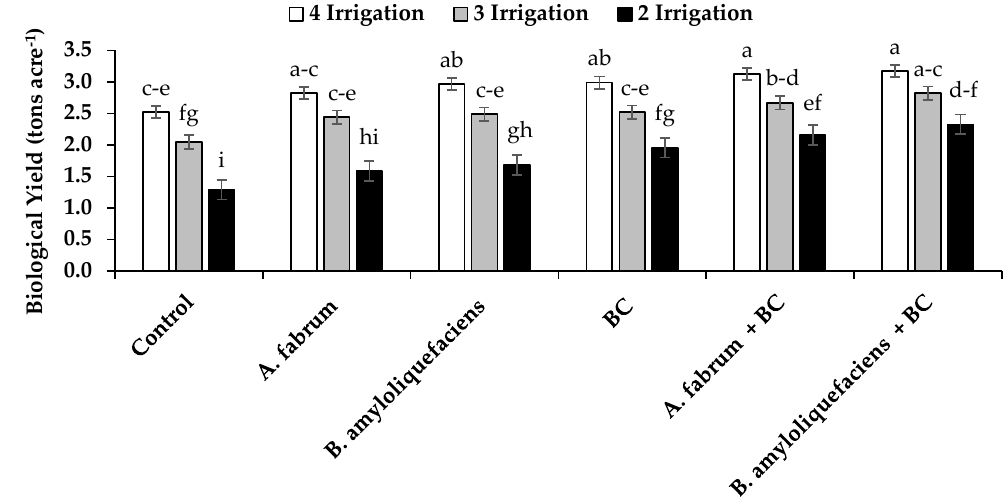
Figure 3. Effect of Agrobacterium fabrum , Bacillus amyloliquefaciens with/without biochar (30 Mg ha − 1 ) on biological yield (tons acre − 1 ) in wheat cultivated in drought-stressed field conditions.